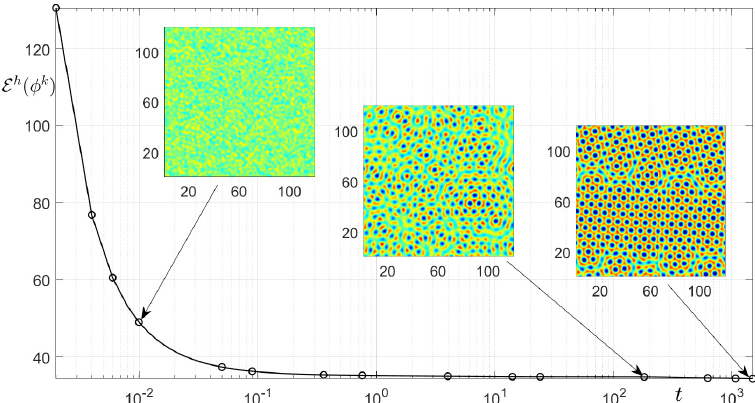
Figure 18. Energy dissipation over time, Equation (49) , to the classical PFC model with the initial condition (50) . Note that t -axis is on